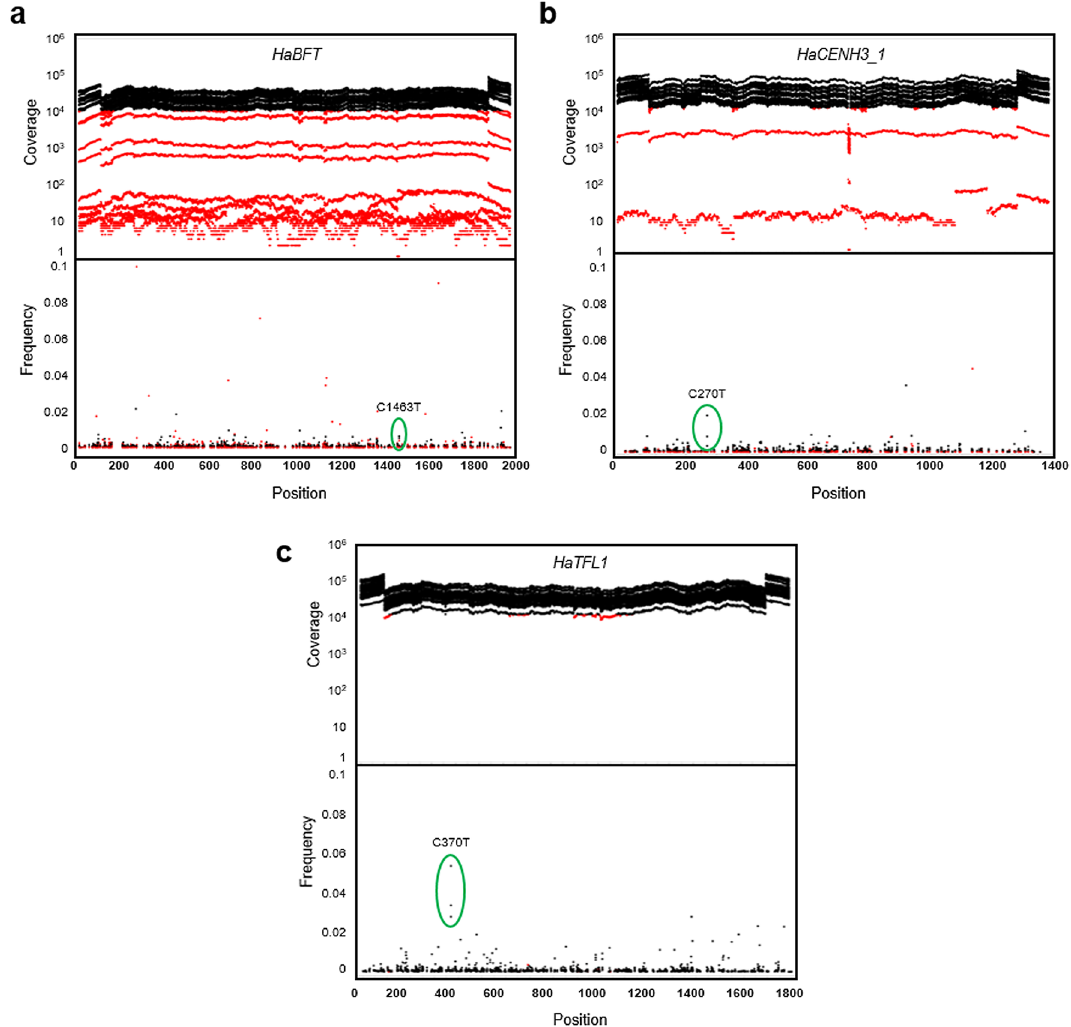
Figure 2. Effect of sequencing coverage on mutation detection and noise. Shown are results from 24 libraries constructed from PCR products generated from 512 three-dimensionally pooled genomic DNA samples. Sequence coverage and mutation frequency are shown for three genes: HaBFT (a) , HaCENH3_1 (b) , and HaTFL1 (c) . Each gene is represented in a separate panel that illustrates the per-base sequencing coverage in 24 libraries (top panels) and observed frequency of C > T changes (bottom panels). In both panels, base positions with coverage below 12,000-fold are represented in red to highlight the contribution of low-coverage bases to noise. Mutant individuals shared by three pools represented by three outliers are also indicated by green